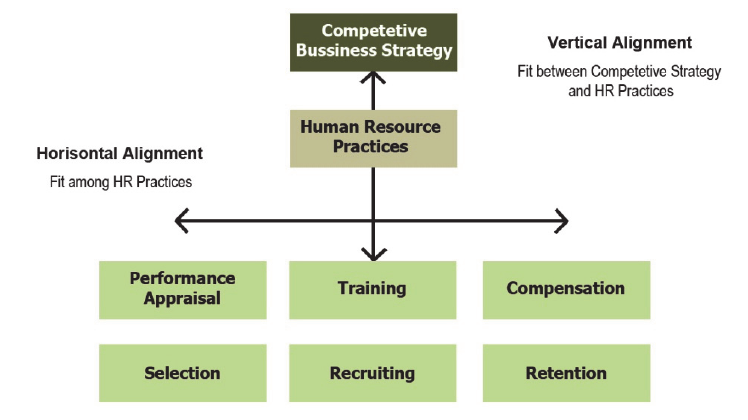
Fig. 1. Vertical and Horizontal